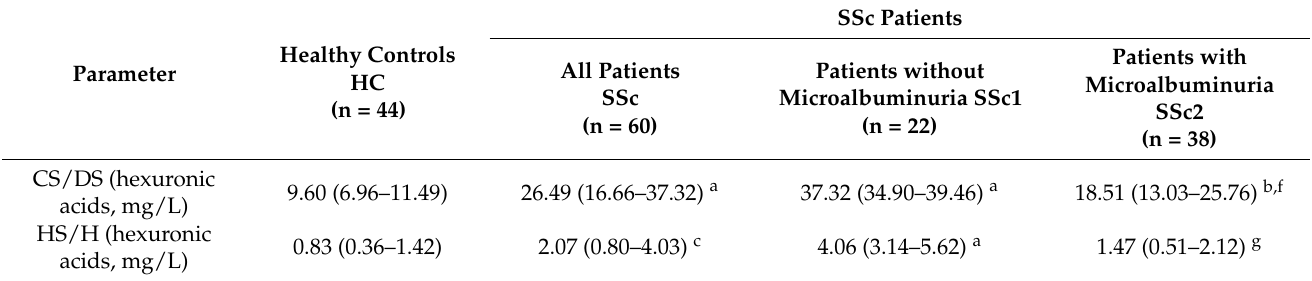
Table 2. The distribution patterns of plasma CS/DS, HS/H, HA, KS, IL-17, IL-18 and urinary (u) CS/DS, HS/H, HA in the healthy controls and SSc